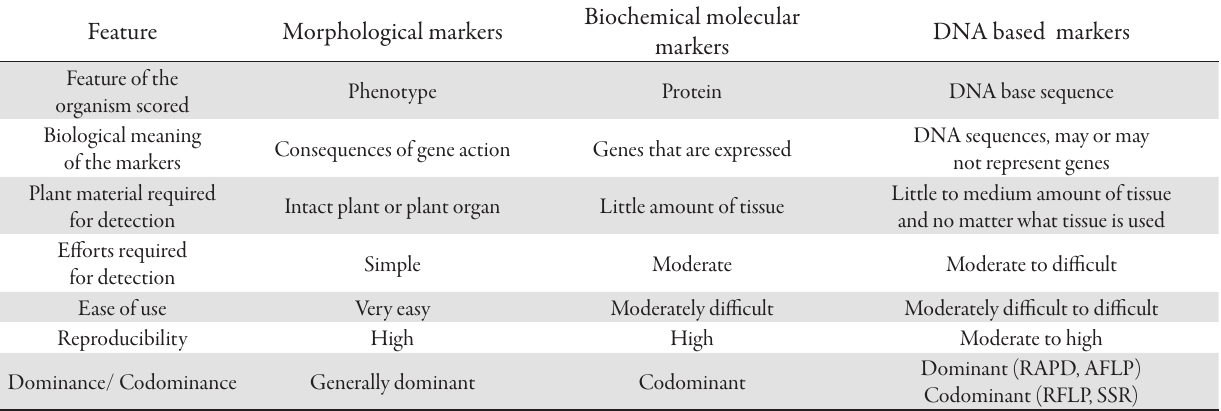
Tab. 1. Comparison between morphological, isozyme and DNA markers